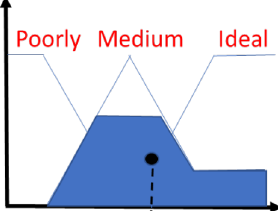
Fig. 4. Representation of the output Fuzzy sets resulting from a centroid defuzzi fi